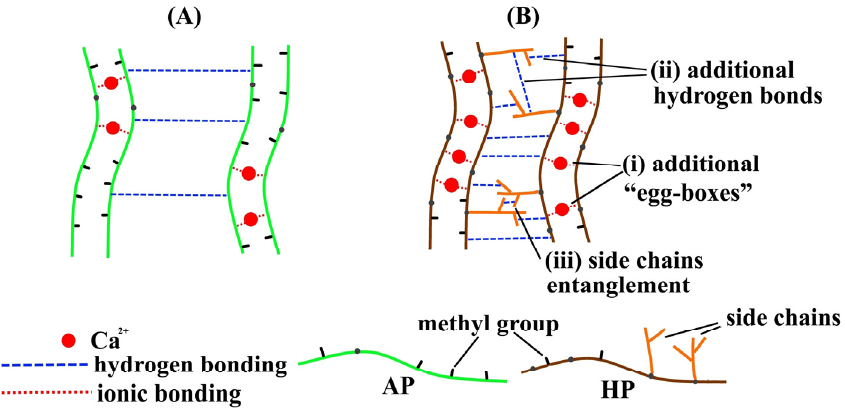
Figure 2. Scheme of a proposed chain interaction in AP ( A ) and HP ( B ) hydrogels. Suggested reasons for strengthening the HP hydrogel: (i) an increase in the number of Ca 2+ crosslinks due to a lower degree of esterification; (ii) the formation of additional hydrogen bonds due to more sugar side chains; and (iii) the entanglement of sugar side chains.